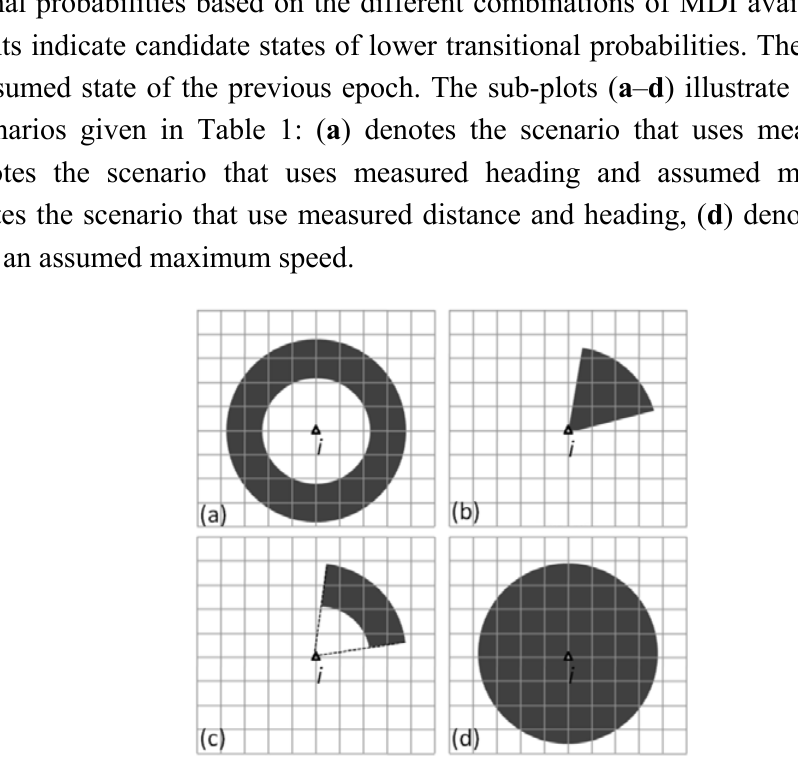
Figure 6. The grid points in the black areas indicate candidate states that have higher transitional probabilities based on the different combinations of MDI available. The other grid points indicate candidate states of lower transitional probabilities. The triangle point i is the assumed state of the previous epoch. The sub-plots ( a – d ) illustrate respectively the four scenarios given in Table 1: ( a ) denotes the scenario that uses measured